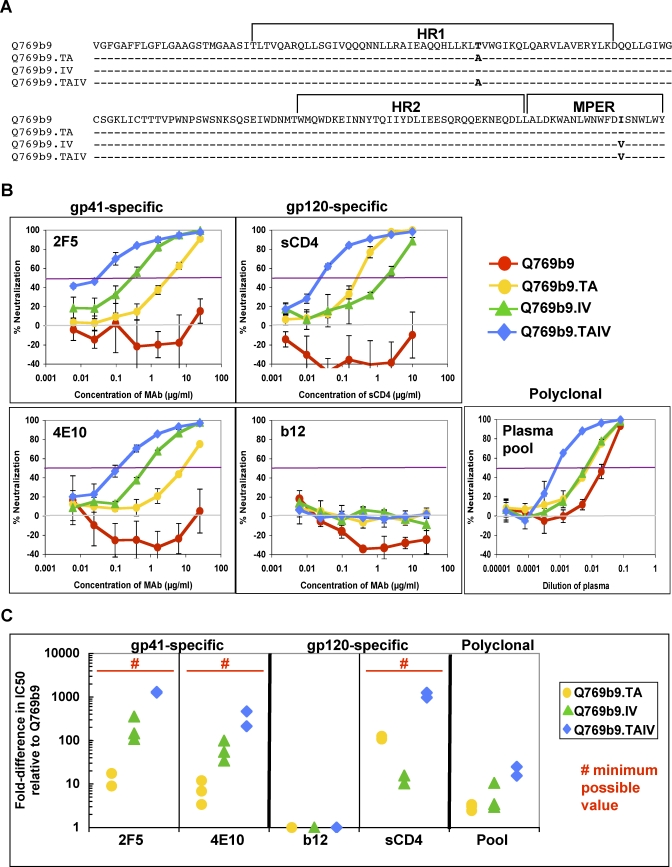
Sequence, Infectious Titer, and Neutralization Profiles of Q769b9 Envelope Variants(A) The predicted gp41 amino acid sequences of Q769b9 and the TA, IV, and TAIV mutants. Layout is as described in the legend to Figure 1A.(B) Neutralization curves of pseudotyped viruses made with the Env variants described in (A) are shown. The layout is as described in the legend to Figure 1B.(C) The -fold difference in the IC50 for the Q769b9 mutants relative to Q769b9 is shown on a log scale as in Figure 1C.